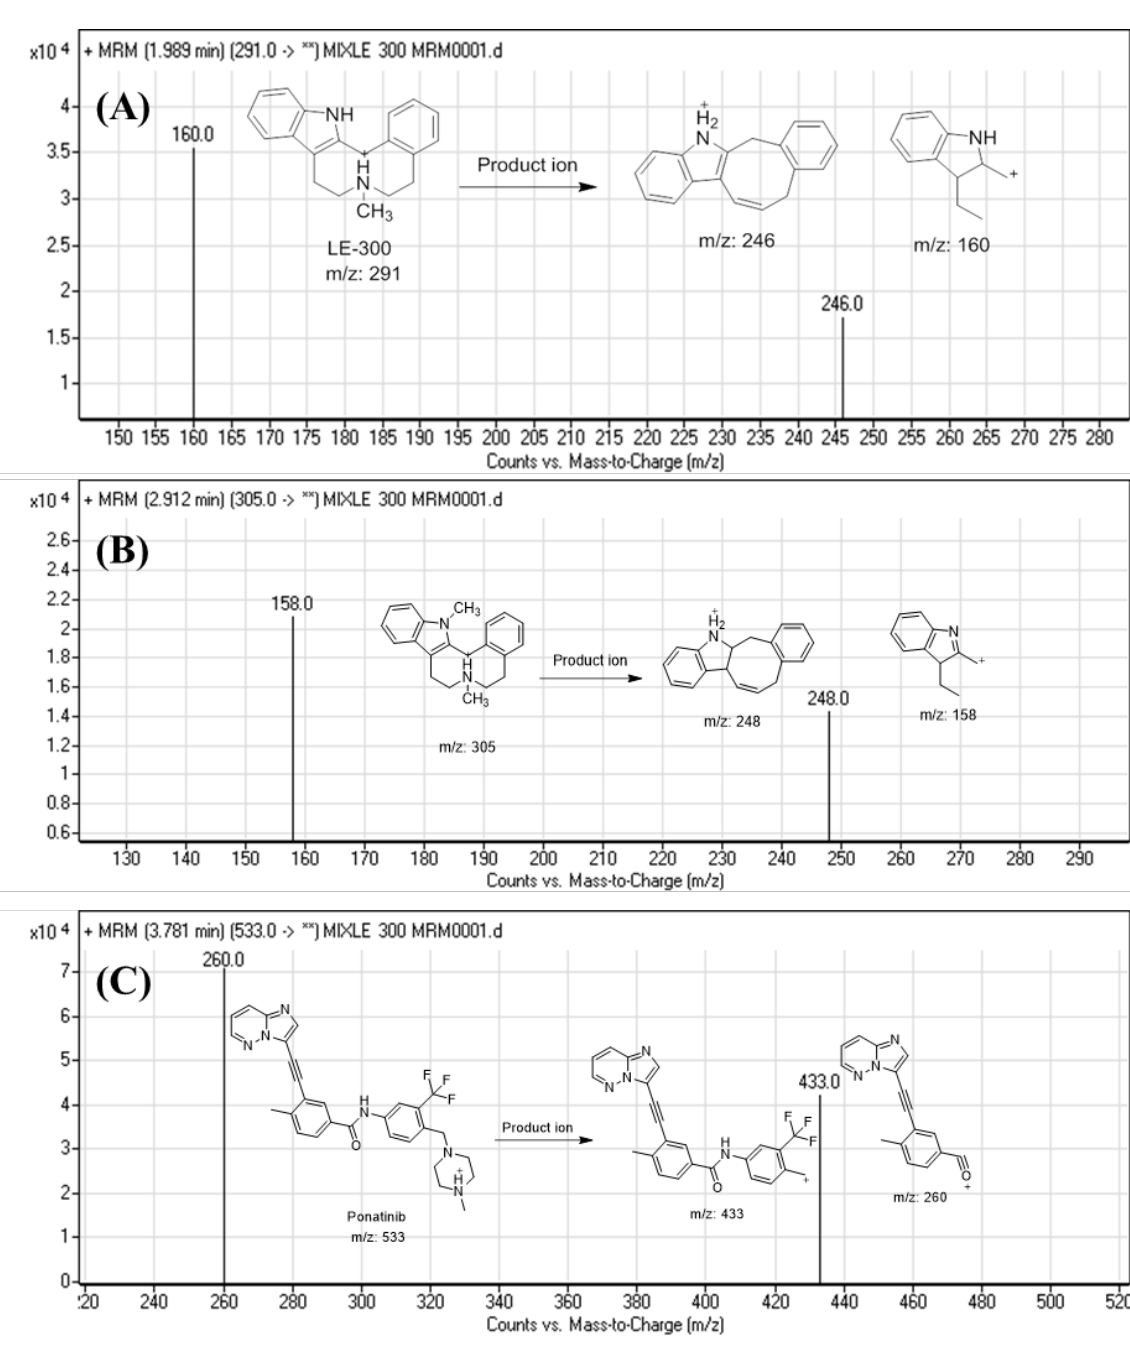
Figure 3. MRM spectra and the proposed PIs of ( A ) LE300, ( B ) MLE300, and ( C ) IS. Figure 4. MRM spectra and the proposed PIs of ( A ) LE300, ( B ) MLE300, and ( C ) IS. Table 1. MRM mode